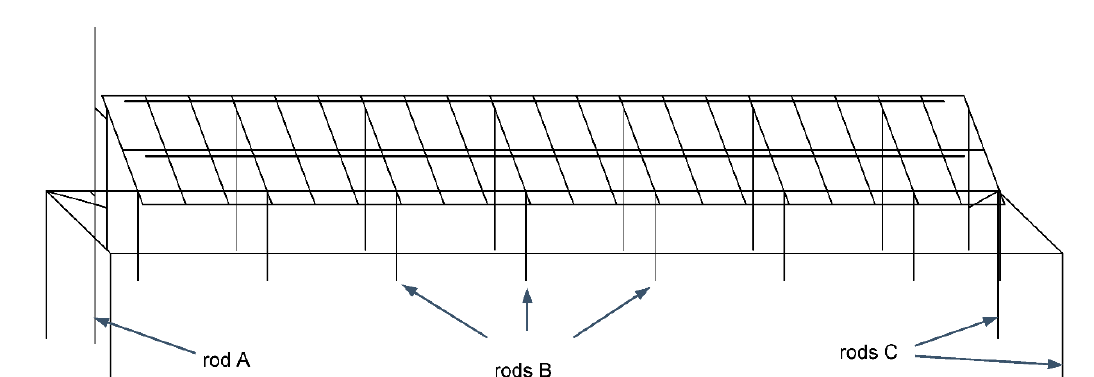
Figure 9. 3d simulation model indicating the structure of the examined grounding systems. Table 2. Examined grounding systems (gs) characteristics (see Figure 9 for rods A, B, and C).